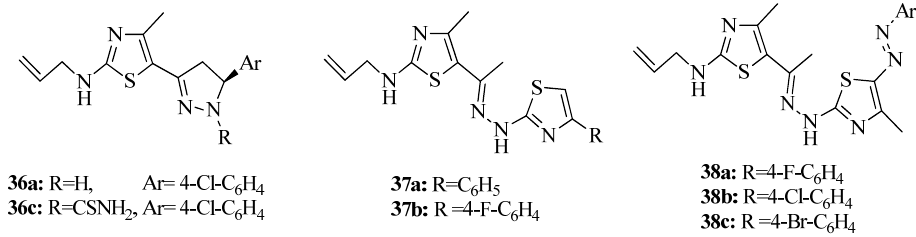
Figure 14. Structures of functionalized 5-hetarylthiazole.